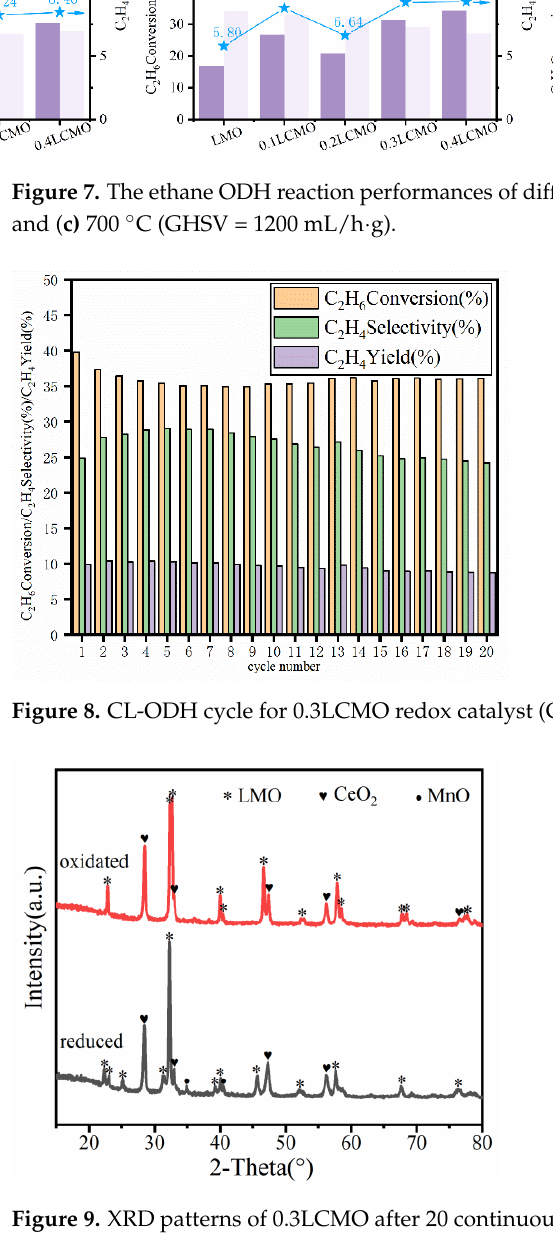
Figure 10. SEM images of 0.3LCMO after circulation.